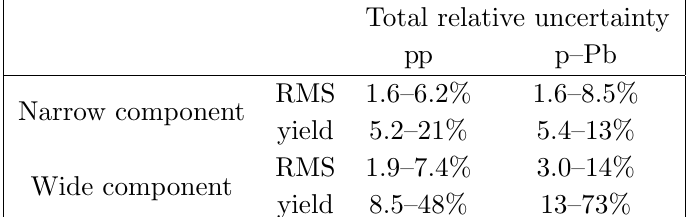
Table 1 . Total systematic uncertainties for RMS and yield of the narrow and wide components in pp and p{Pb collisions. The ranges re(cid:13)ect p Tt and x for